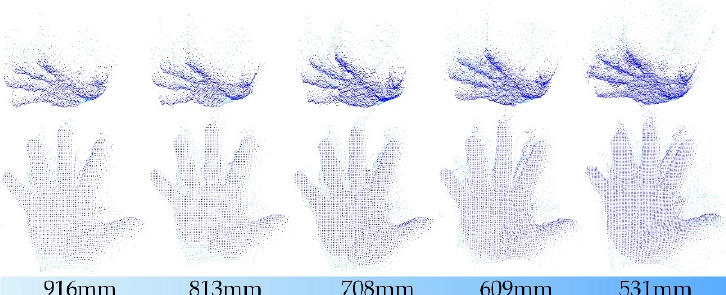
Figure 1. Point clouds of the human hand at different distances. The distance values are obtained by calculating the average of 25 × 25 pixels depth at the center of the hand.